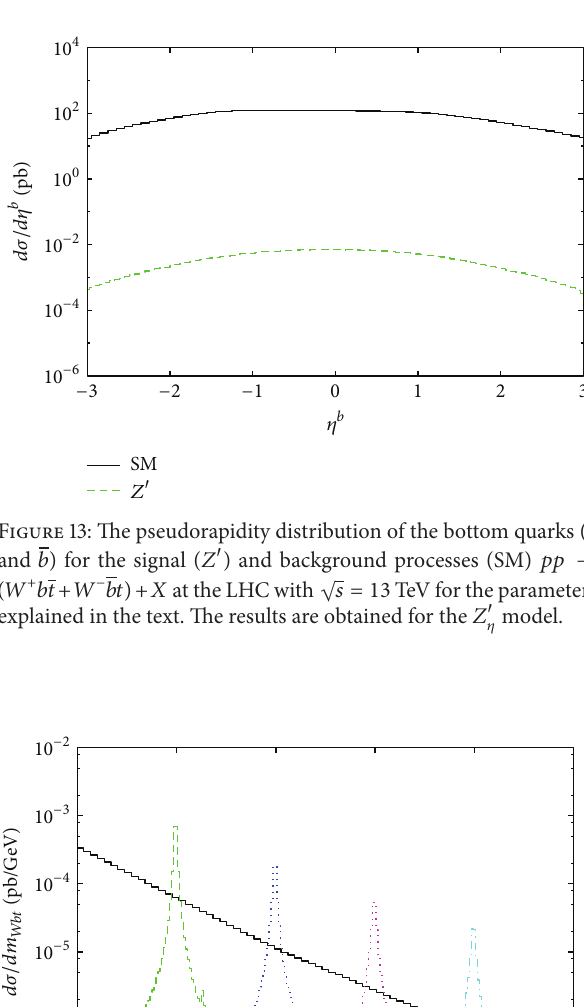
We plot the observability contours in the plane of model parameters (𝑥 − 𝑀 𝑍 󸀠 ) , for different 𝑍 󸀠 models as shown in Figure 18 at the LHC with √𝑠 = 13 TeV and 𝐿 int = 100 fb −1 . The curves with labels 𝑍 󸀠 accessible regions (below the curves) of the model parameters at the LHC. For the 𝑍 󸀠 𝜂 model, the FCNC parameter bounds from 𝑥 = 0.6–0.4 can be searched for the mass range of 𝑀 𝑍 󸀠 = 1500–3000